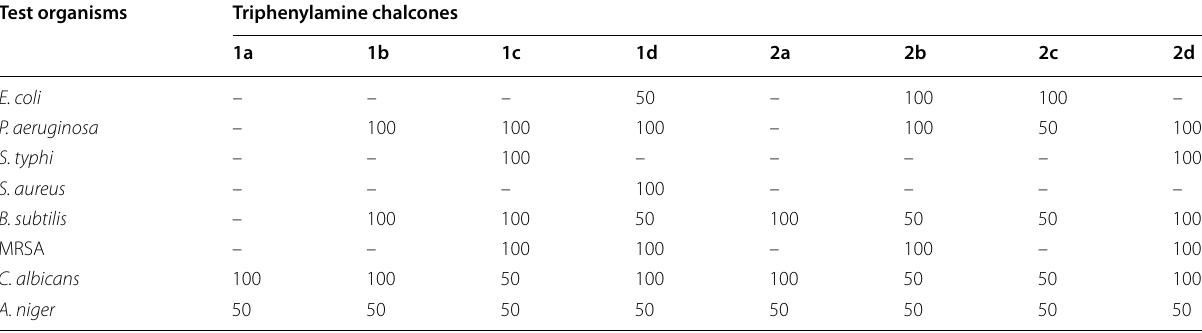
Table 4 Minimum bactericidal/fungicidal concentrations (MBC/MFC) of the synthesized compounds